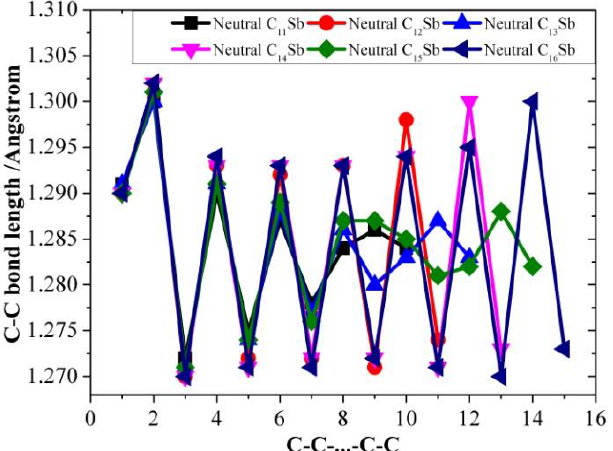
Figure 2. C-C bond length alteration of neutral C 16 Sb,C 16 Sb + cation, C 16 Sb − anion, and pure carbon chain C 16 as a function of number of carbon atoms.